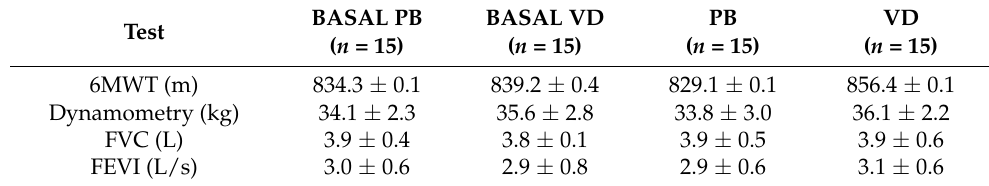
Table 5. Spirometry and physical condition